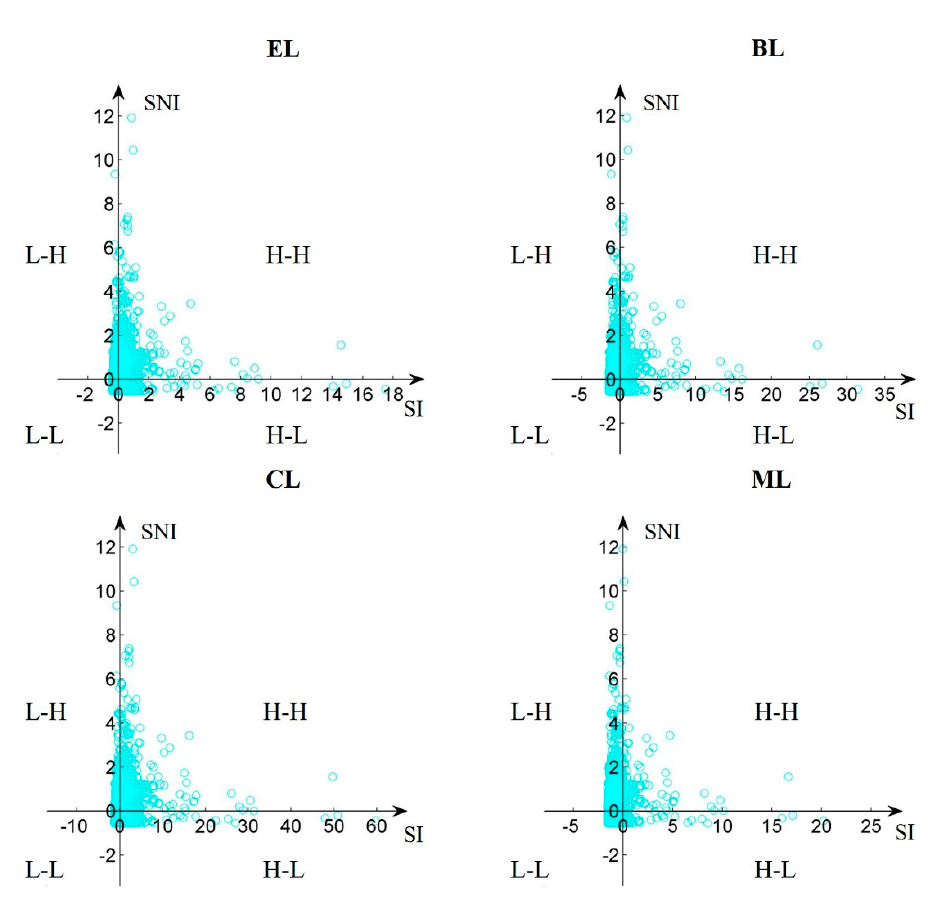
Figure 5. LS mismatch between the supply and demand. Table 4. Distributions of the numbers of different supply-demand patterns in Beijing, China, 2019.